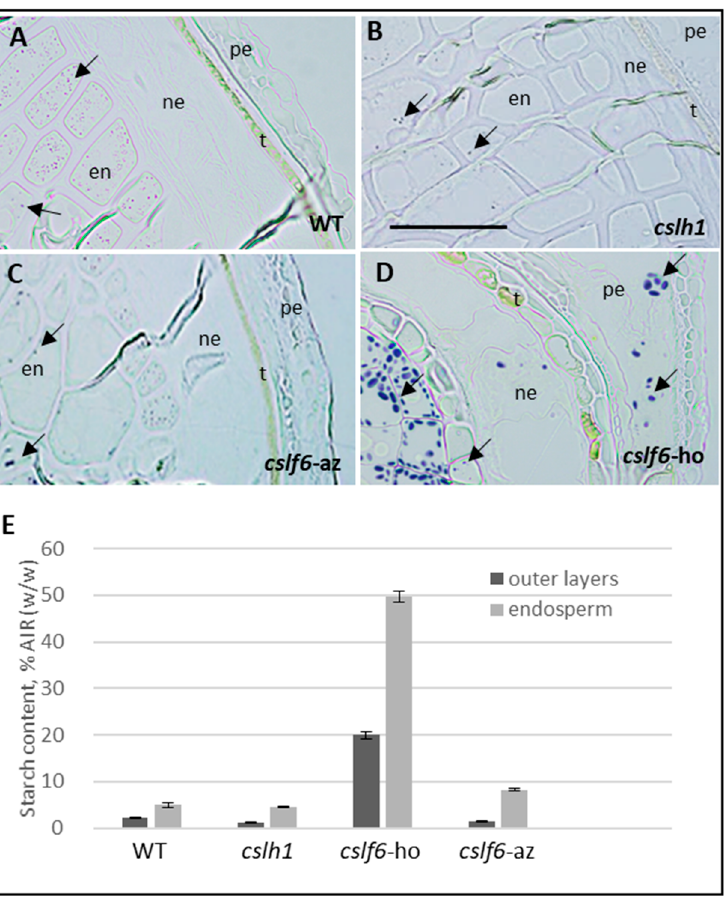
Figure 8. Localization of starch in grains of cslf6 and cslh1 mutants and controls (WT and azygous cslf6 ). ( A – D ): Bright-field images of grain cross-sections stained with iodine. Scale bar: 50 µ m. pe: pericarp; ne: nucellar epidermis; en: endosperm; t: testa. ( E ): Total amount of starch expressed as a percentage of AIR ( w / w ). Arrows indicate starch granules. cslf6 -ho: homozygous cslf6 mutant; cslf6 -az: azygous cslf6 mutant.